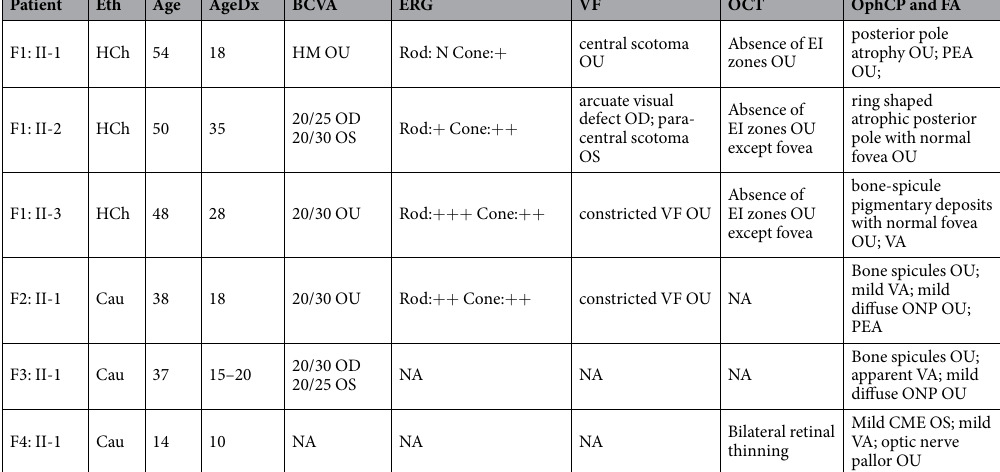
Table 1. Ophthalmological findings in the patients. Eth, ethnicity; HCh, Han Chinese; Cau, Caucasian; AgeDx, Age of diagnosis; BCVA, best corrected visual acuity; HM, hand motion; OU, both eyes; OD, the right eye; OS, the left eye; NA, not available; ERG, electroretinogram; + , mild reduction; ++ , moderate reduction; +++ , severe reduction; VF, visual field; OCT, optical coherence tomography; EI, ellipsoid and interdigitation; OphCP, ophthalmoscopy; FA, fundus autofluorescence; PEA, pigmented epithelial atrophy; VA, vascular attenuation; ONP, optic nerve pallor; CME, cystoid macular